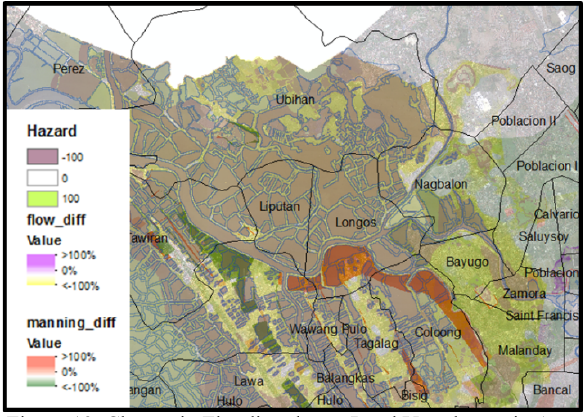
Figure 13. Change in Flooding due to Land Use change in Area